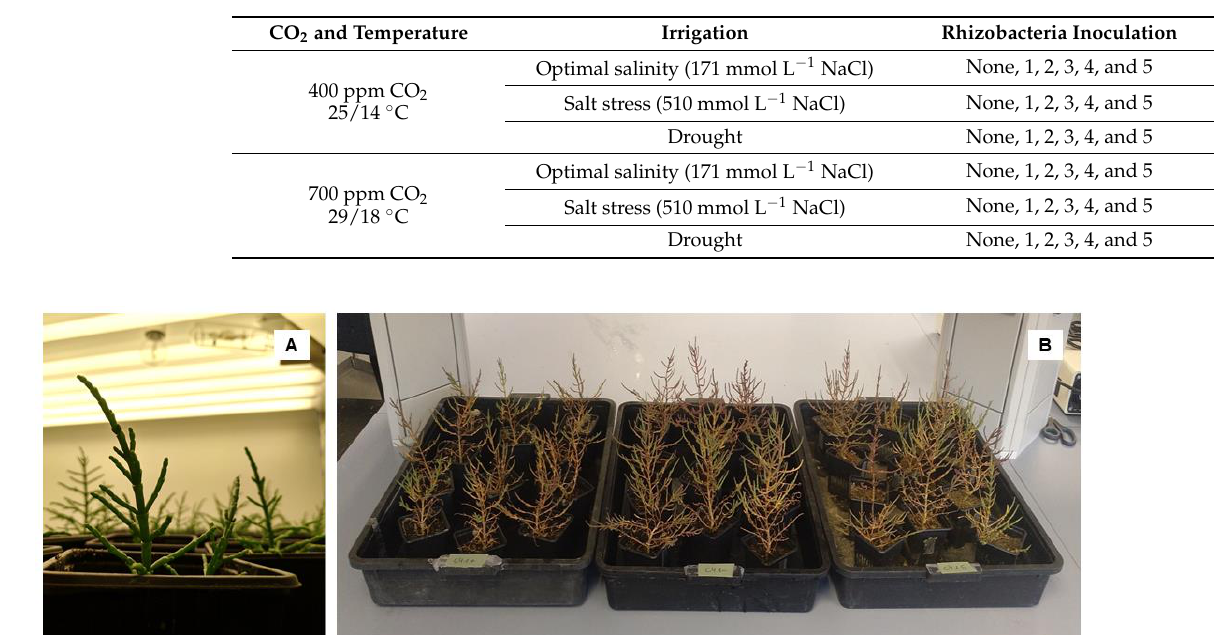
Table 3. Overview of the 36 treatments applied to S. ramosissima plants in our experiment.